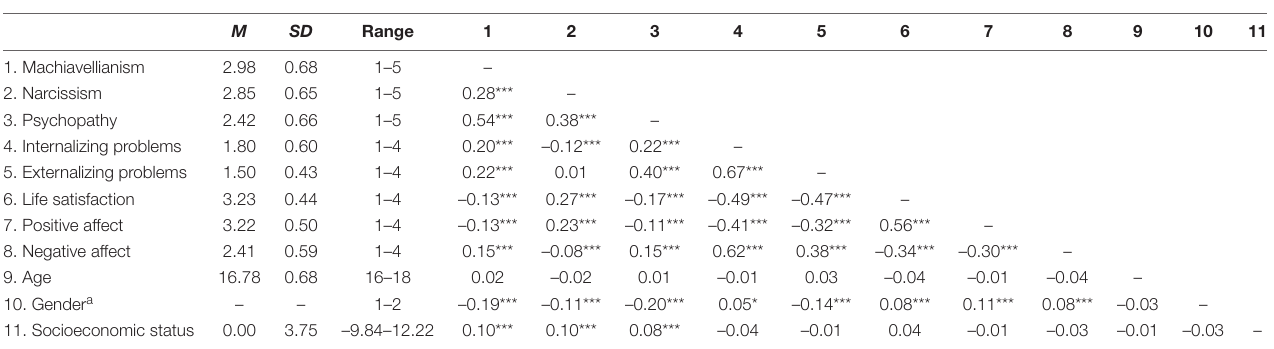
TABLE 1 | Descriptive statistics and bivariate correlations of study variables for Chinese high school students.